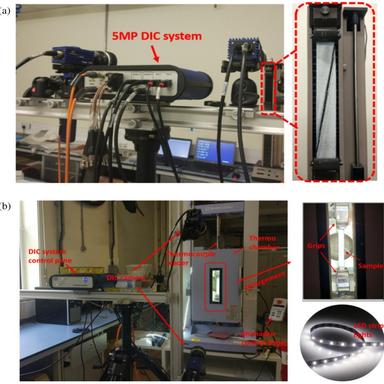
Test set-ups for (a) Initial room temperature tests and (b) Elevated temperature tests. (For interpretation of the references to colour in this figure legend, the reader is referred to the web version of this article.)